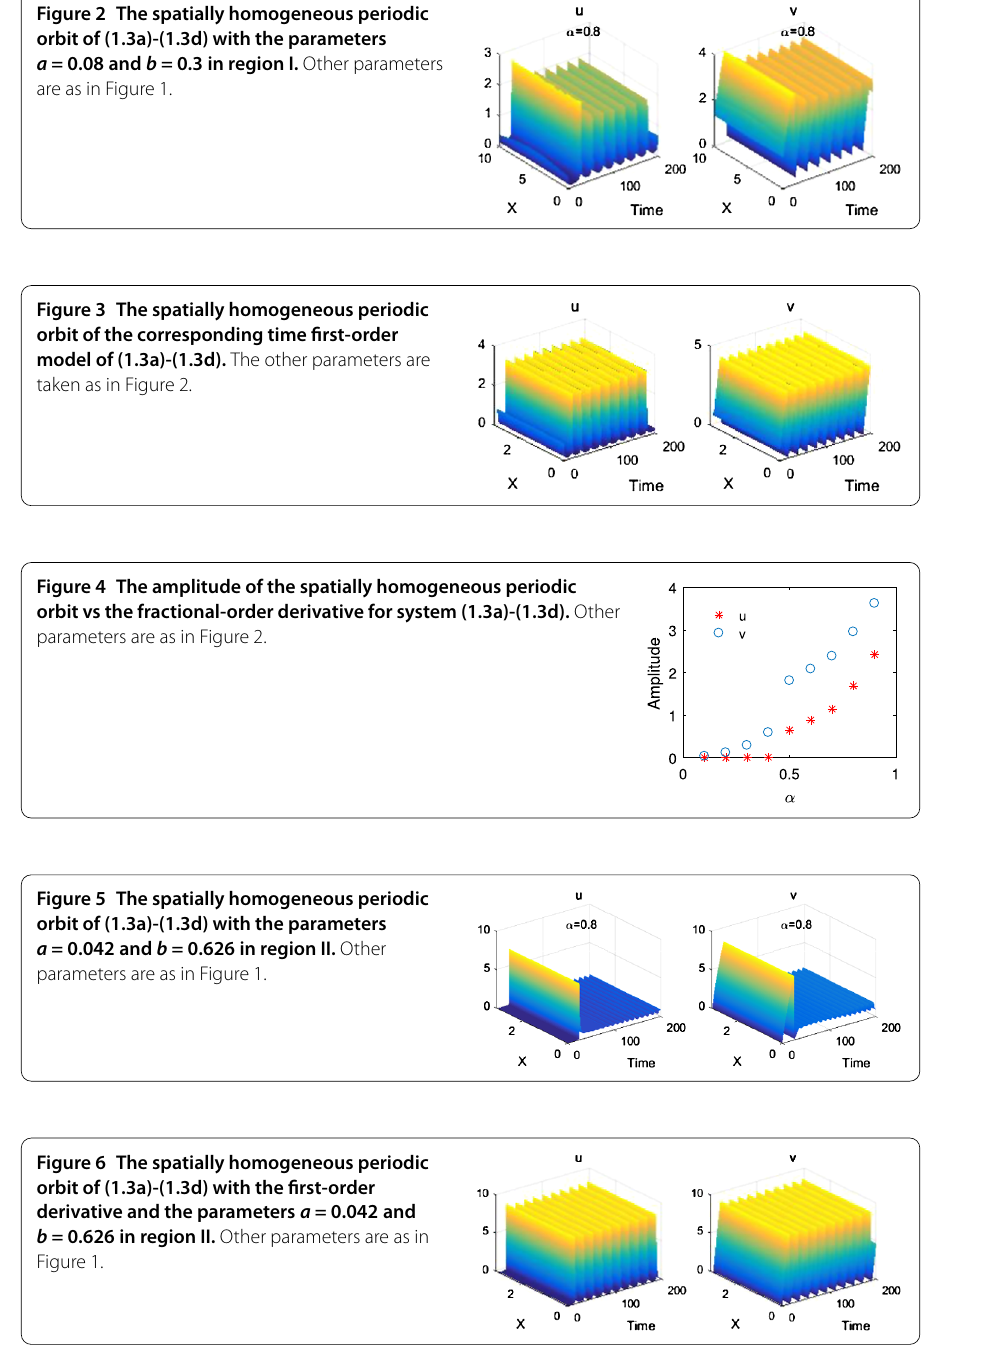
Figure 2 The spatially homogeneous periodic orbit of (1.3a)-(1.3d) with the parameters a = 0.08 and b = 0.3 in region I. Other parameters are as in Figure 1.